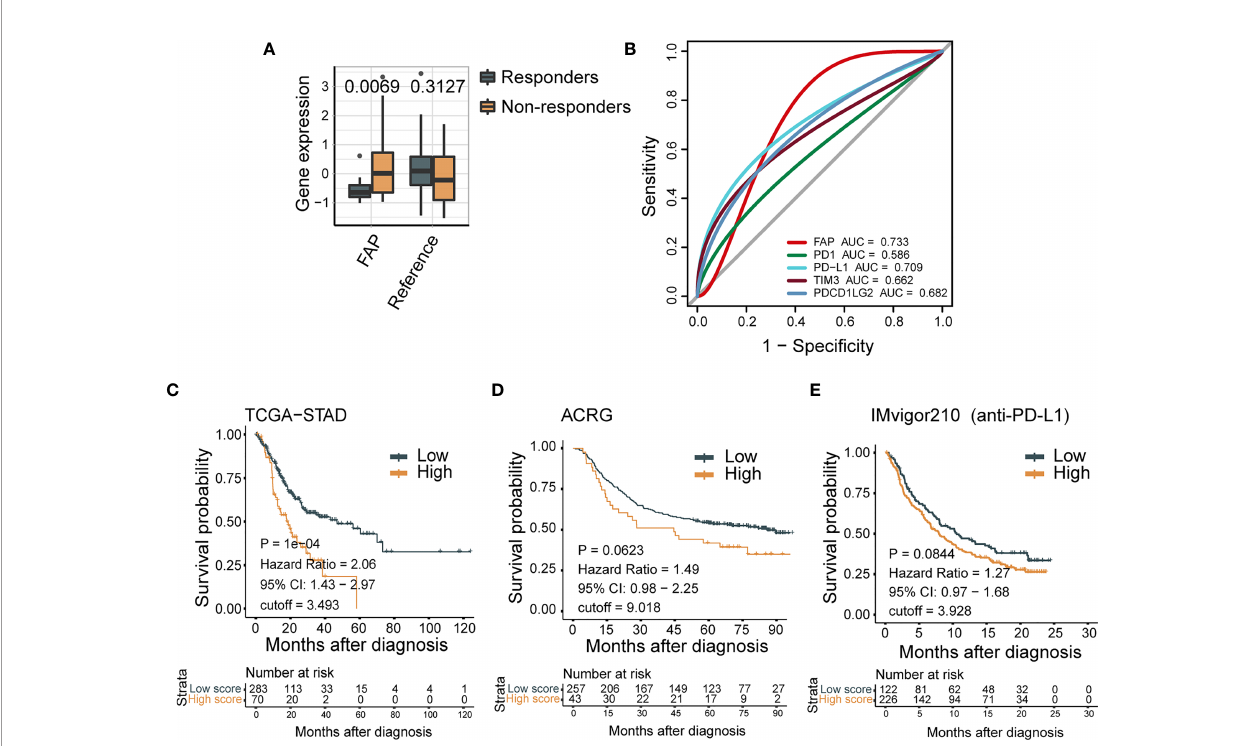
FIGURE 1 | High expression of FAP indicates poor tumor prognosis. (A) FAP mRNA expression negatively correlates with response for ICB treatment in GC patients from Nanostring cohort ( N = 48). (B) ROC curves measure the predictive value of FAP, PD-1, PD-L1, TIM3, and PDCD1LG2 in the Nanostring cohort ( N = 48). The areas under the ROC curves are 0.733, 0.586, 0.709, 0.662, and 0.682 for the FAP, PD-1, PD-L1, TIM3, and PDCD1LG2, respectively. (C – E) FAP expression is negatively correlated with clinical outcome in a variety of tumors. In Kaplan-Meier analysis of the TCGA-STAD cohort (C) , ACRG cohort (D), and IMvigor210 cohort (E) , higher FAP expression indicates shorter overall